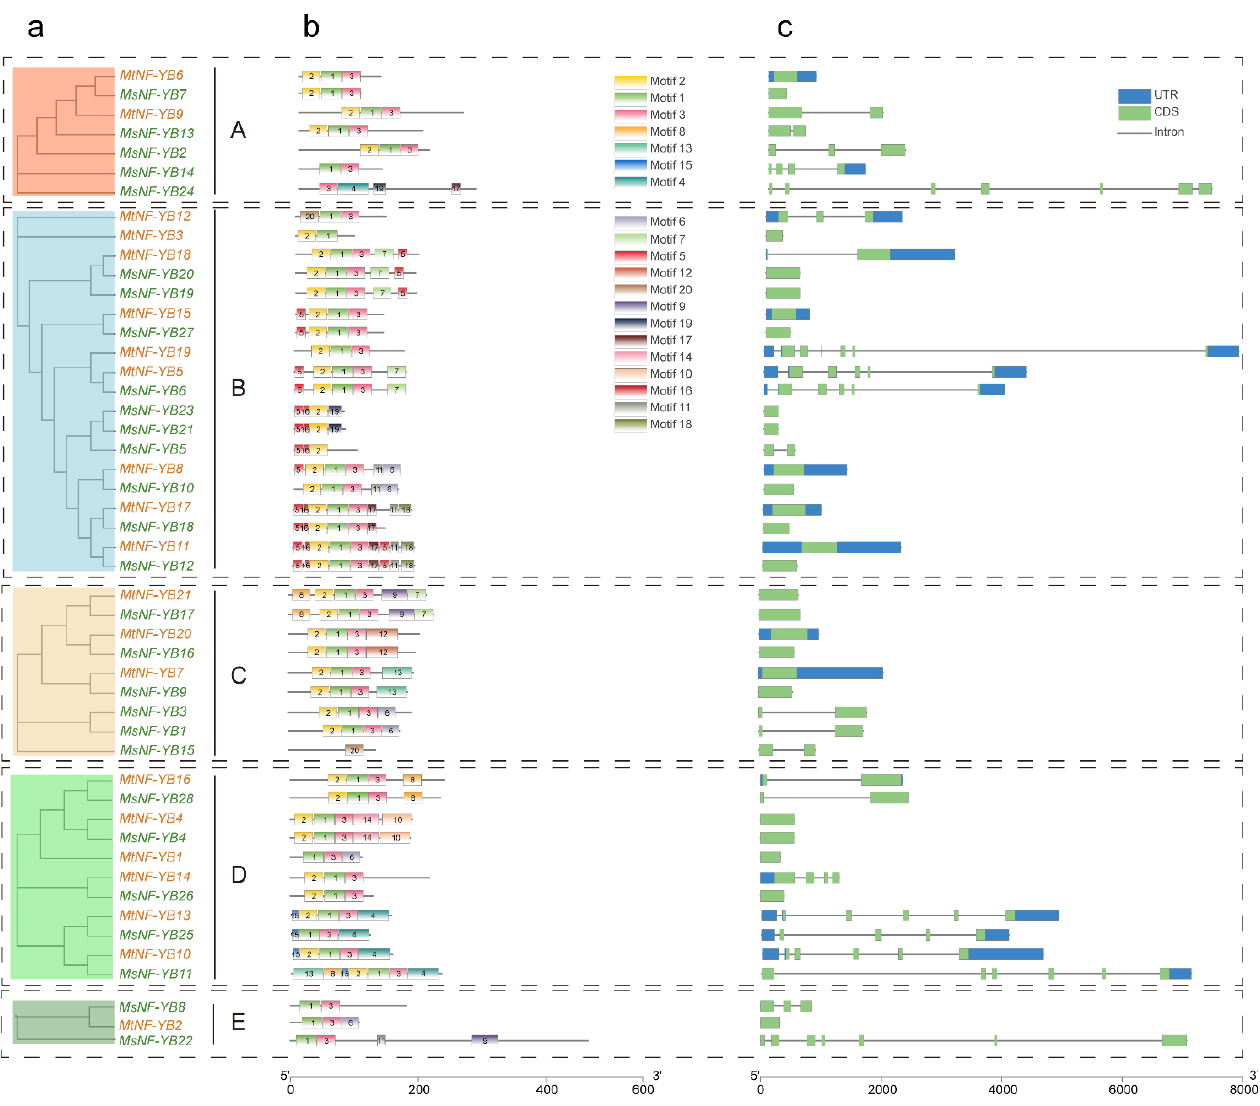
Figure 3. Phylogenetic relationships, motifs, and gene structure of NF-YB genes from M. truncatula and M. sativa ( a – c ). The groups and color of the phylogenetic tree are the same as in Figure 2. The motifs are indicated in different colored boxes with different numbers, and sequence information for each motif is provided in Supplementary Figure S1. Blue boxes indicate 5 ′ - and 3′ - untranslated regions; green boxes indicate exons; black lines indicate introns.